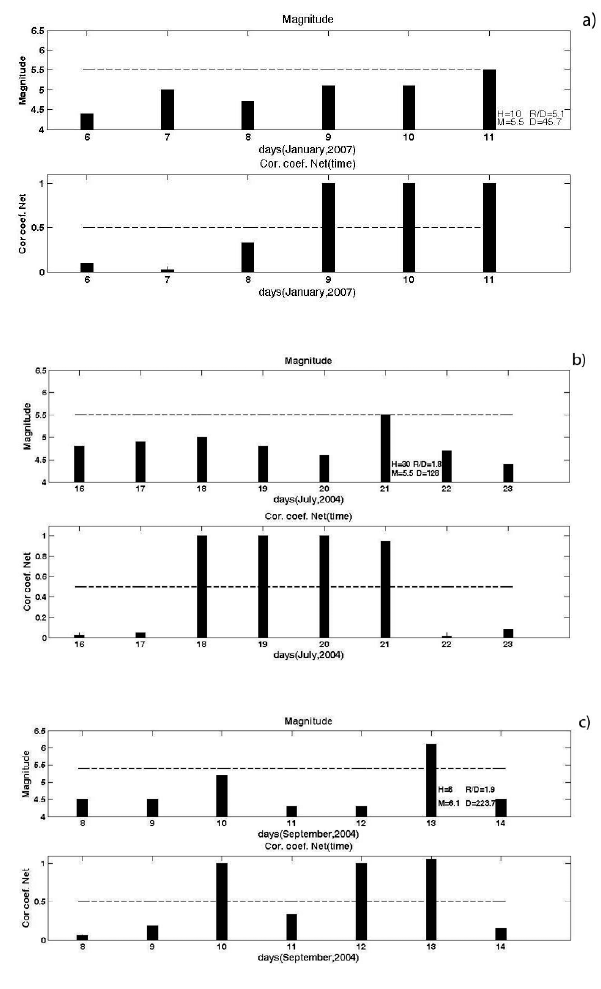
Figure 3. The neural network prediction. (a) Result of prediction for January 6-11, 2007. (b) Result of prediction for July 16-23, 2004. (c) Result of prediction for September 8-14, 2004. Each column on the upper section represents the magnitude of the earthquakes that oc- curred on certain days of the time period considered. If M ≥ 5.5, the corresponding column is marked with the following parameters: magnitude M, depth H, distance D from the epicenter of the earth- quake to the axis of the ‘transmitter–receiver’ line, and the ratio R/D. Dashed line, threshold at which M ≥ 5.5. The corresponding values of the correlation coefficients are presented in the bottom section: dashed line, threshold of the correlation coefficient of